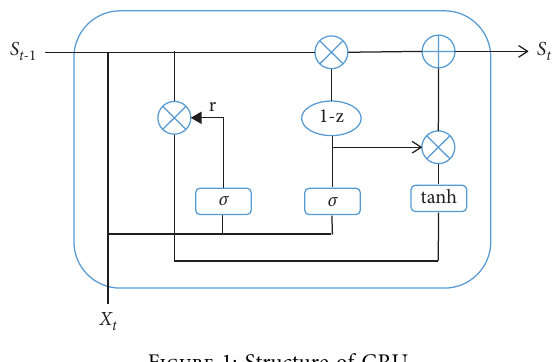
Figure 1: Structure of